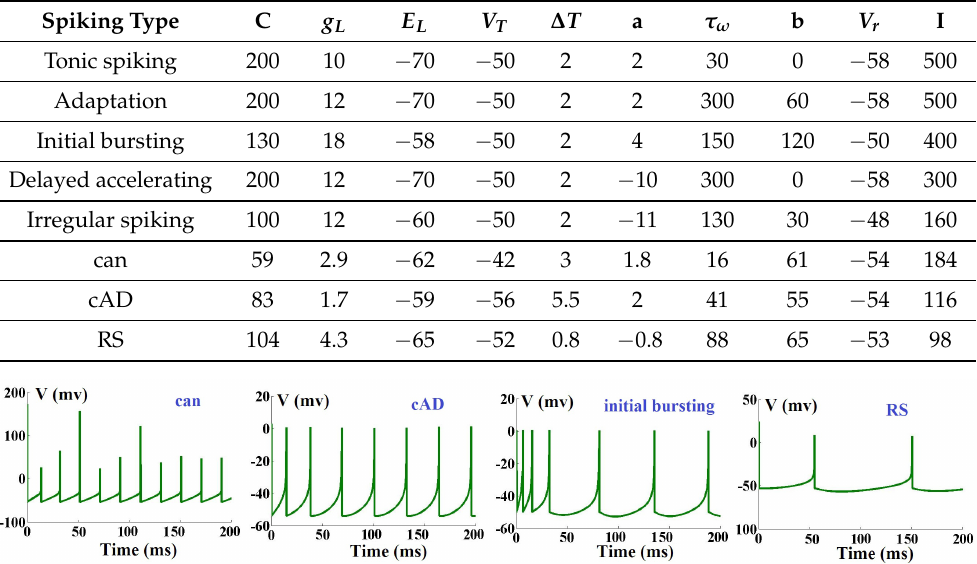
Figure 1. Some spiking patterns extracted by the original ADEX neuron